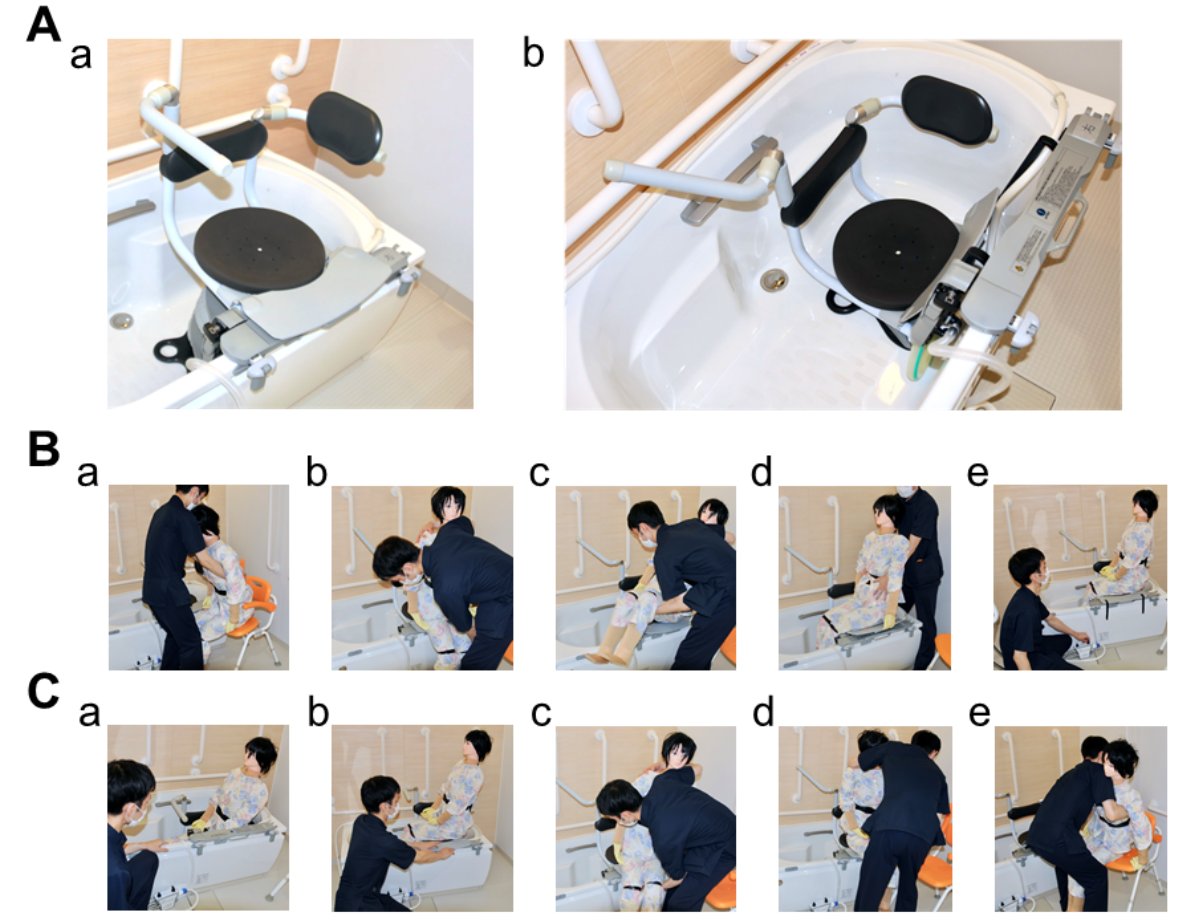
Figure 1. Experimental paradigm. ( A ) A picture of the bathing support device “Bath Assist” (BA). ( B ) Bathing assistance getting into the bathtub with BA. Initially, the care recipient, who is sitting in the shower chair, is lifted (a) and transferred into the seat of BA (b). Next, the seat is rotated while the care recipient’s legs are moved into the bath (c). Finally, after adjusting the care recipient’s posture (d), the seat is lowered using water pressure by turning the lever in the controller (e). ( C ) Bath- ing assistance getting out of the bathtub with BA. Initially, the seat is raised using water pressure by reversing the lever in the controller (a,b). Next, by rotating the seat of the BA, the legs of the care recipient are lifted (c) and finally transferred to the shower chair (d,e). In this figure, a life-sized mannequin was used as a patient to simulate bathing assistance.